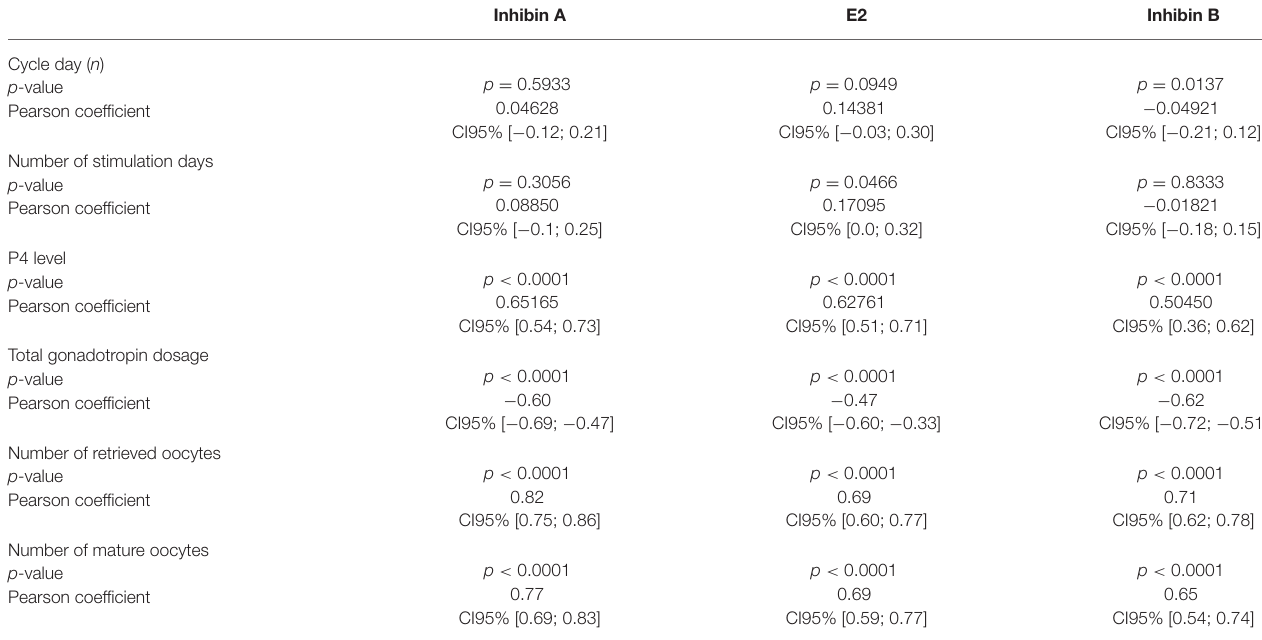
TABLE 4 | Correlations on the day of final oocyte maturation between the stimulation parameters and Inhibin A, estradiol, and Inhibin B. Inhibin A E2 Inhibin